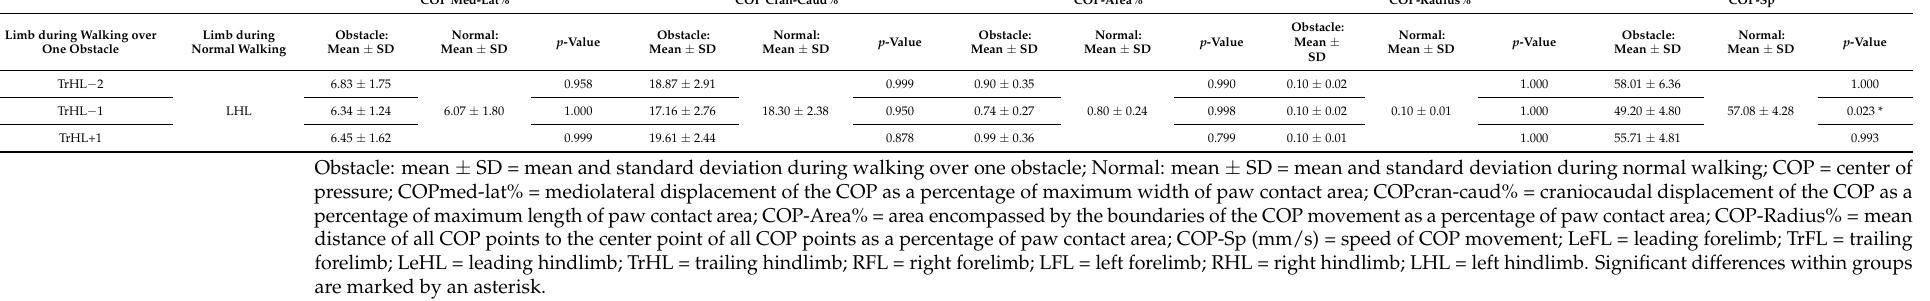
Limb during Walking Over Two